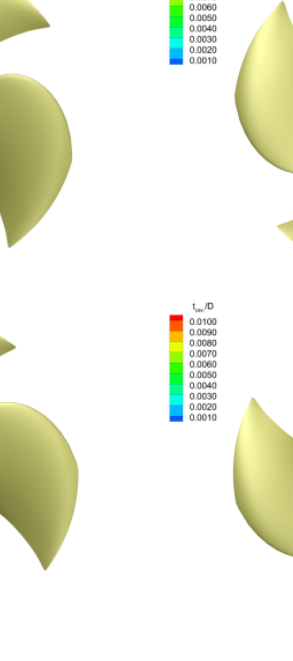
Figure 10: Predicted cavity extension (BEM) with Nominal-LDV inflow wake.